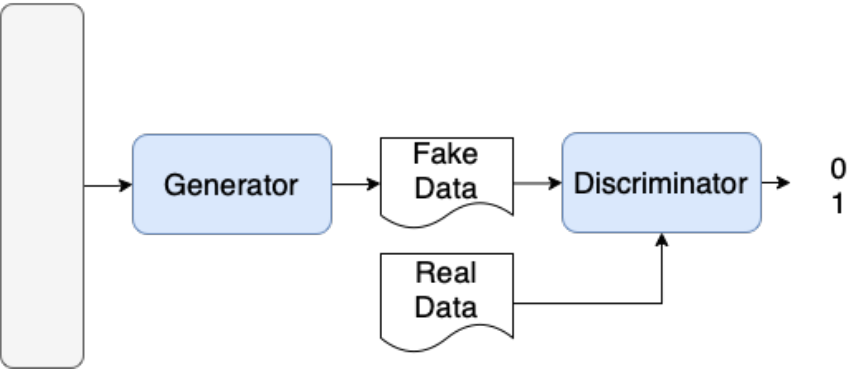
Figure 4. Example of Generative Adversarial Network (GAN) [21,22].